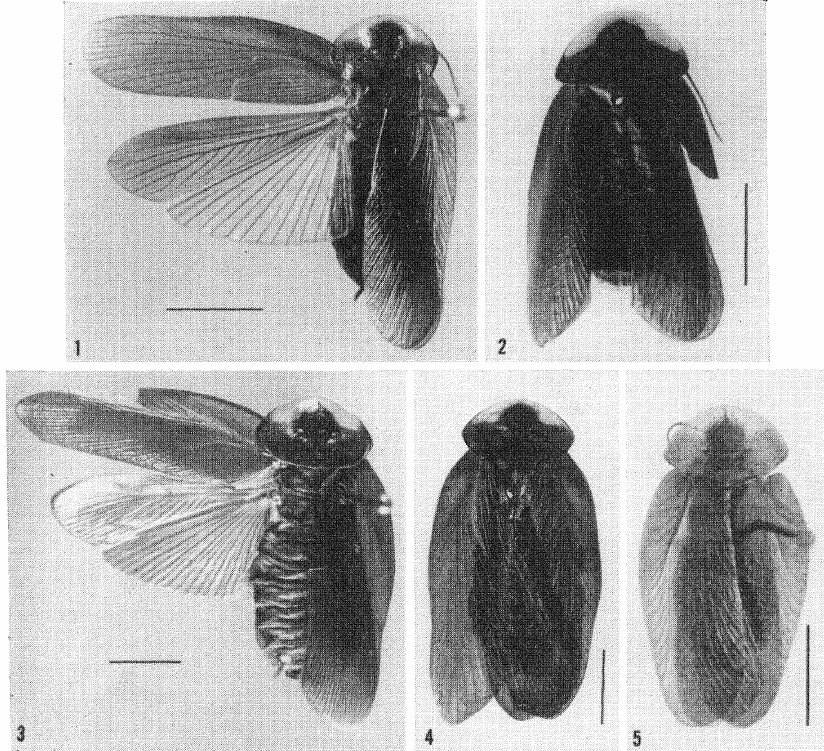
Figs. 1-5. 1. (105 ANSP). Zetobora signaticollis Burm. Curityba, Brazil (det. Hebard). 2. (6 BMNH). Zetobora transersa (Brunner). Rio de Janeiro, Brazil. 3. (106 ANSP). Zetobora ampla (Hebard). Paratype. Montagnes Des Orgues, Prov. de Rio Janeiro, near Tijuca, Brazil. 4. (7 BMNH). Zetobora monastica Sauss. 5. (113 ANSP). Phortioecoides guaran Rehn. Paratype. Horqueta, Paraguay u40 Km east of Rio (57W, 23N). (scale